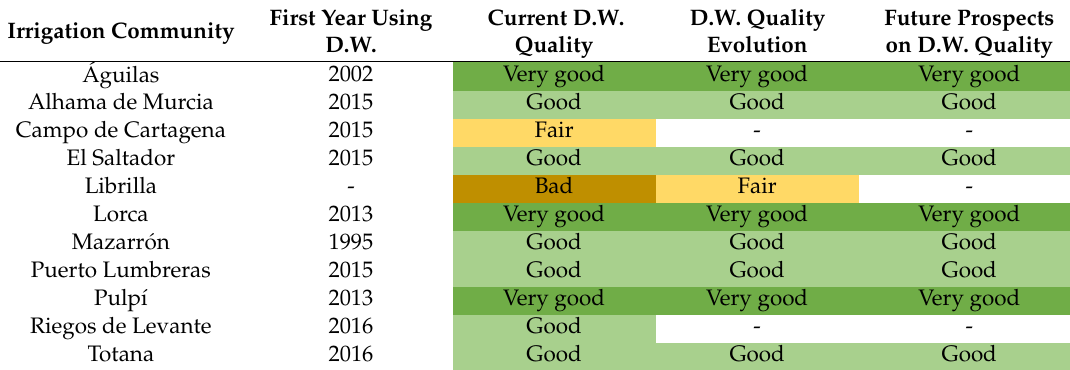
Table 2. Perception of desalinated water quality by irrigation communities. First Year Irrigation Community